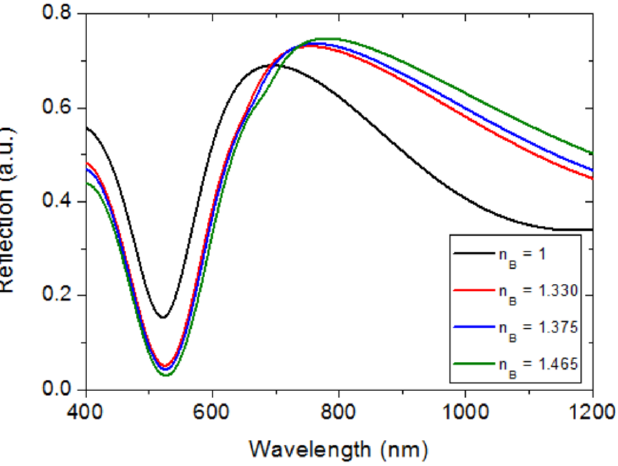
Figure 10. Calculated spectral reflections of the modeled Au NP/SiO 2 /Ti/Mo configuration for different values of the bulk refractive index n B .